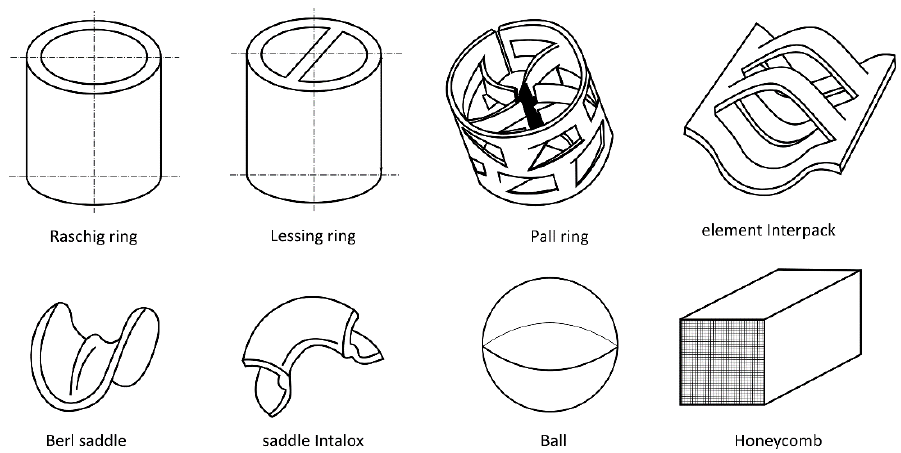
Figure 1. Some types of geometry of storage materials [1].